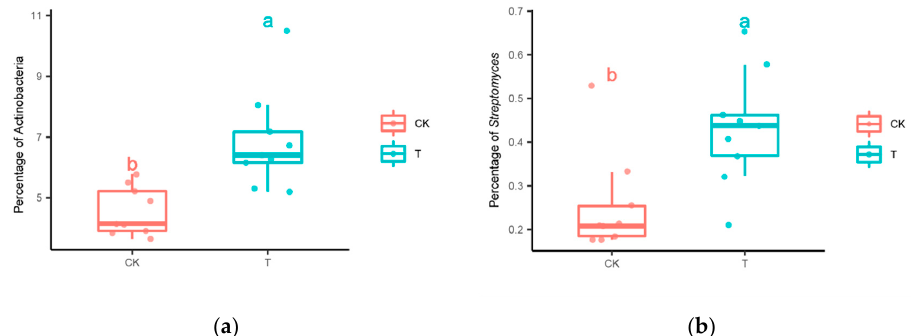
Figure 4. Variation in the relative abundance of the phylum Actinobacteria ( a ) and genus Streptomyces ( b ) in the rhizosphere soil of cucumber inoculated with Streptomyces (T) and without Streptomyces inoculation (CK). The horizontal bars within boxes represent the medians. The tops and bottoms of boxes represent the 75th and 25th percentiles, respectively. The upper and lower whiskers extend to data no more than 1.5× the interquartile range from the upper edge and lower edge of the box, respectively. Different letters above boxes indicate significant differences at p < 0.05.